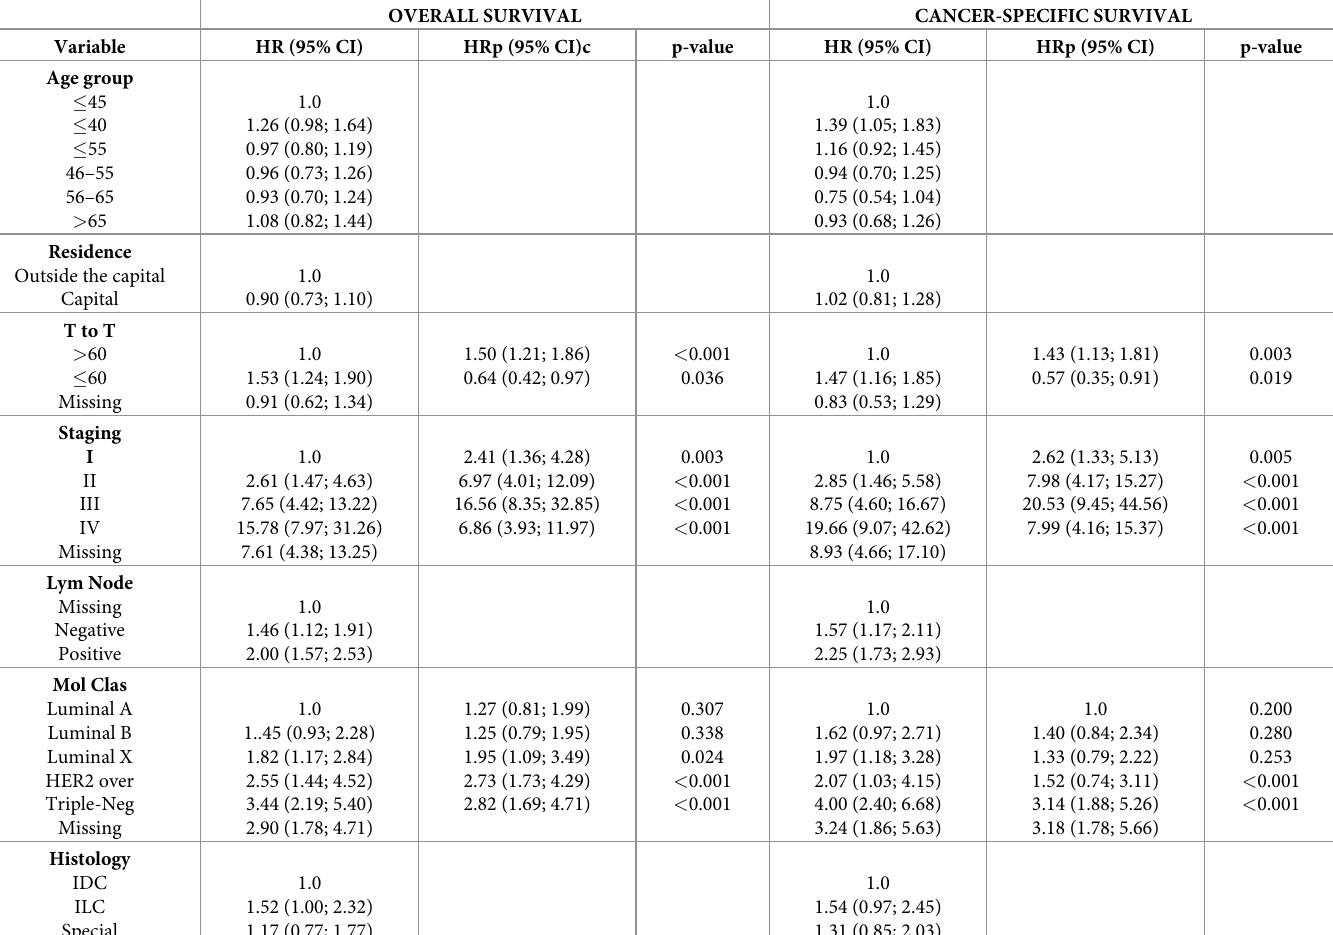
Table 2. Effect of different prognostic factors on the survival probability of patients with breast cancer using the univariate (unadjusted) and multivariate (adjusted) cox regression